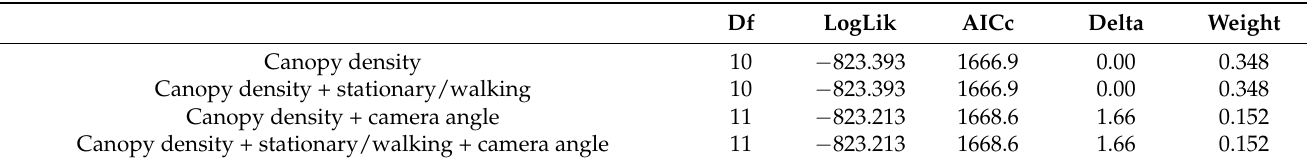
Table A6. The models with the best fit to the RGB data showing AICc and weight values.